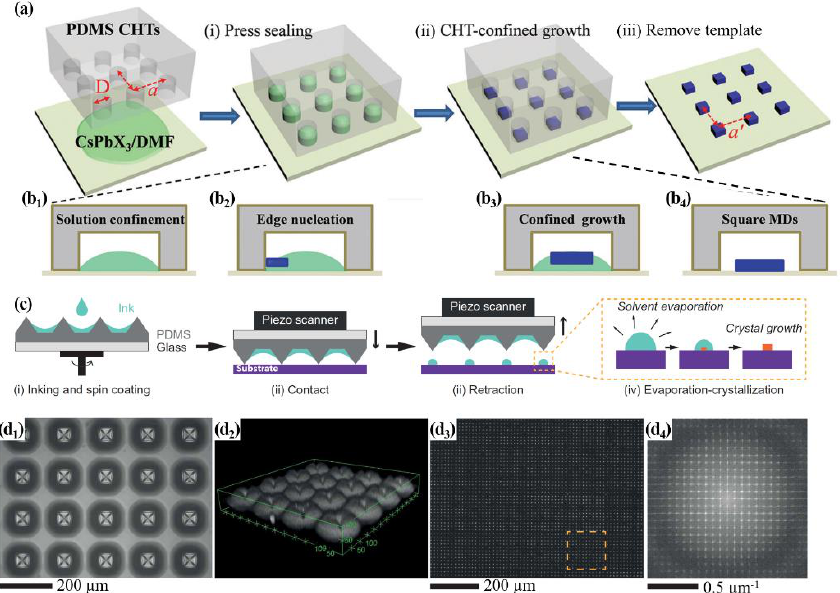
Figure 6. ( a ) Schematic illustrations of the process for fabrication of the micro-disk arrays in CHT- confined area. ( b ) The enlarged images of ( a (i) , a (ii) ); from the nucleation to final nanocrystals (iii) of CsPbX 3 perovskite. Reproduced with permission [58]. Copyright 2017. Wiley-VCH. ( c ) Another fab- rication method for perovskite nanocrystal arrays with PDMS templates called Polymer pen lithog- raphy (PPL); the injection of precursor solutions of MABr and PbBr 2 dissolved in DMSO into the Piezo scanner (i), contact the scanner on a substrate (ii), detach it and leave droplets of the precursor solutions (iii), and evaporation and crystallization of the perovskite nanocrystals (iv). ( d 1 ) A optical micrograph of the precursor solution around the base pyramid in the scanner. ( d 2 ) 3D confocal micro- scopic image of precursor ink with dye after scanner contact on the substrate. ( d 3 ) Fluorescence micro- graph of MAPbBr 3 nanocrystal arrays. ( d 4 ) Fourier transform of orange-dot-square in ( d 3 ). Reprinted with permission [59]. Copyright 2020, American Association for the Advancement of Science.